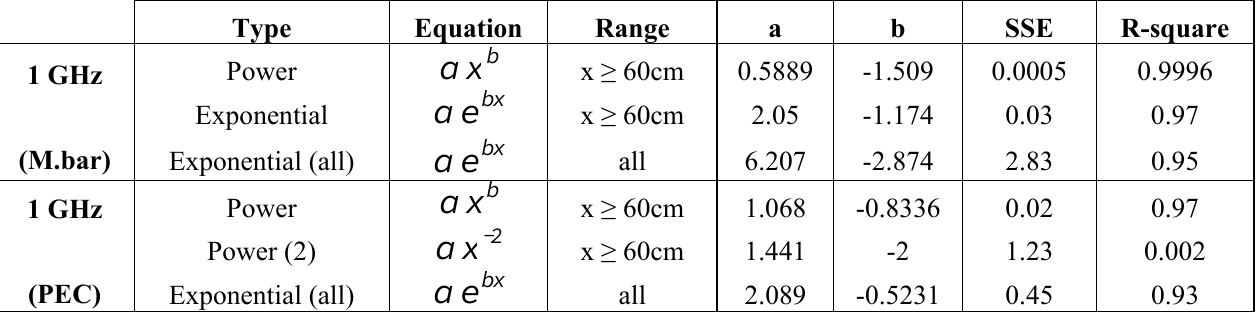
Table 6 . Values that allow the best fit of the regression curves for the 1 GHz antenna. Measurements were obtained with high stacking (512) to ensure adequate signal stability. Concerning the quality of the fit, sum of squared errors (SSE) and correlation coefficient (R-square) parameters are included in the table.